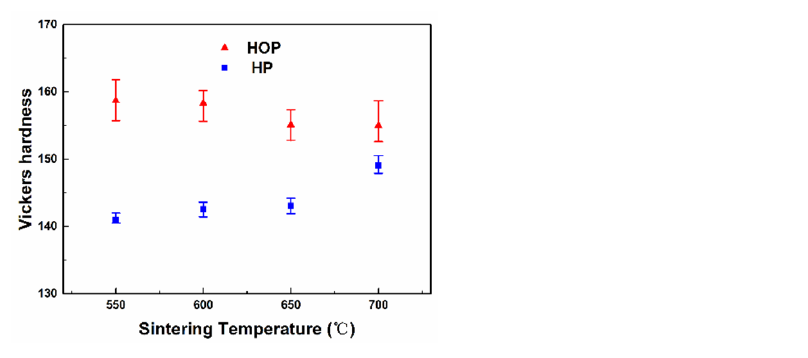
Figure 5. A plot of hardness as a function of sintering temperature for samples sintered by HOP and